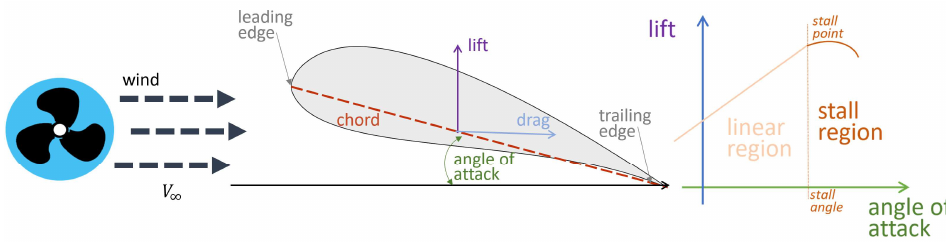
Figure 1. Terminologies of an airfoil used in this work; ( left ) nomenclature, ( right ) elements of the transfer characteristics.